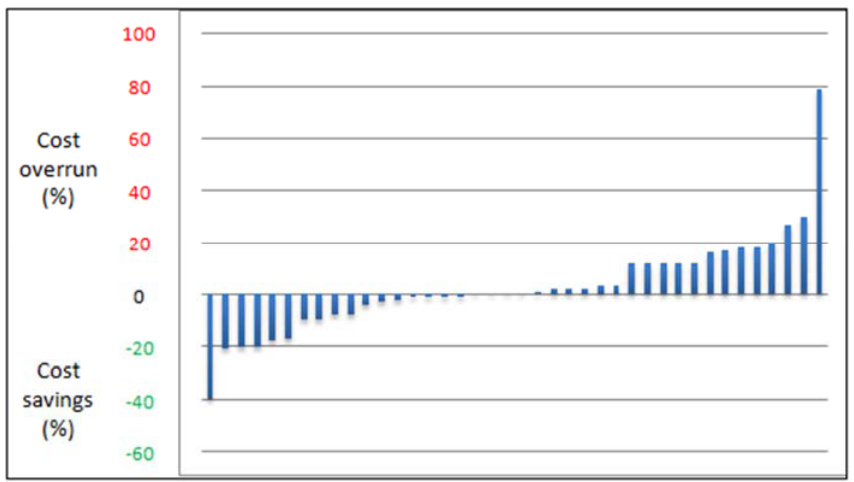
Figure 7. The result of the budget quality audits of all large Norwegian finalized governmental projects qualified while using the Successive Principle from 2000 to 2013. The actual outcomes are compared with the agreed working budgets before execution started (as percent of actual cost). These budgets were typically close to the expected cost. The figures are taken from [19].